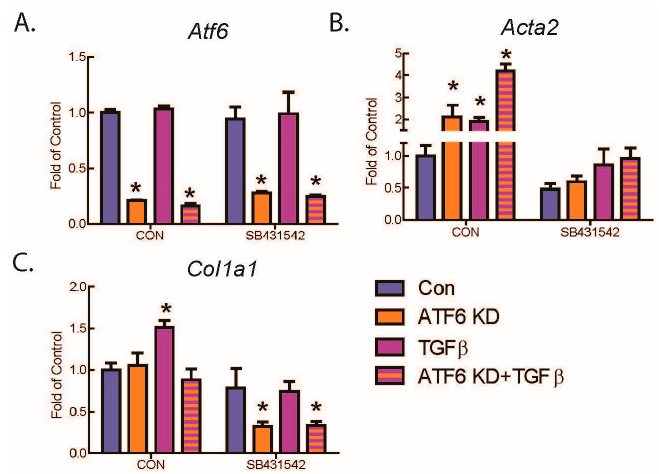
Figure 5. Effect of inhibiting the TGF β RI on ATF6 and TGF β -mediated increases in fibroblast markers. AMVFs were treated with ±siRNA to ATF6, ±10 ng/mL TGF β , ±10 μ M of the TGF β RI inhibitor SB431542, and then analyzed by qRT-PCR for ( A ) Atf6 , ( B ) Acta2 , and ( C ) Col1a1 . All treatments were for 48 h. * p ≤ 0.05 by one-way ANOVA. * Indicates significant difference between a condition and control according to Newman–Keuls post-test.